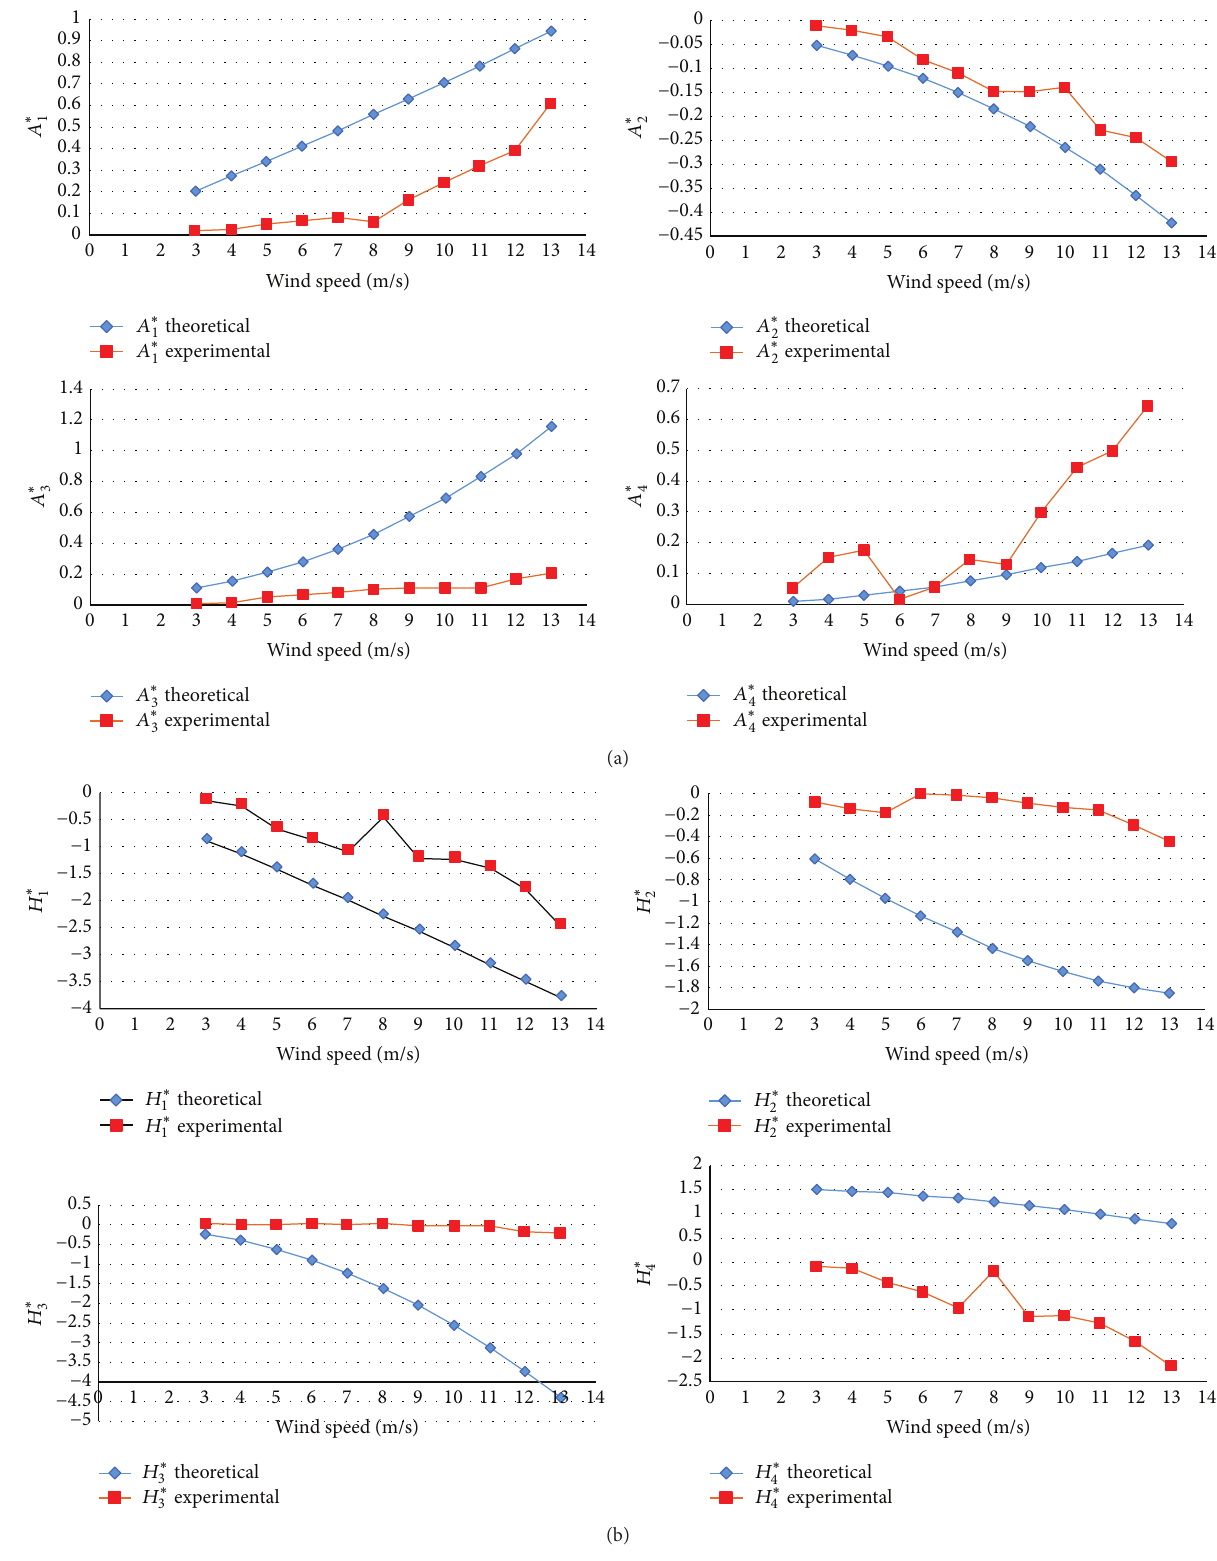
Figure 7: (a) Flutter derivatives 𝐴 ∗ 1 , 𝐴 ∗ 2 , 𝐴 ∗ 3 , and 𝐴 ∗ 4 for the multibox bridge deck estimated by the Theodorsen thin plate theory and determined from experiments. (b) Flutter derivatives 𝐻 ∗ 1 , 𝐻 ∗ 2 , 𝐻 ∗ 3 , and 𝐻 ∗ 4 for the multibox bridge deck estimated by the Theodorsen thin plate theory and determined from